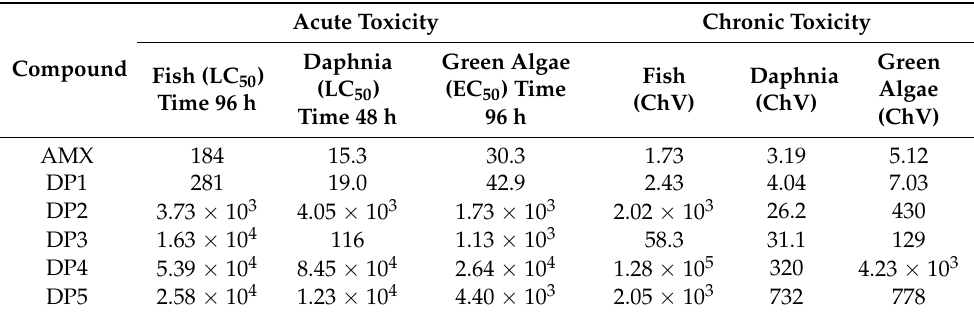
Table 1. Acute and chronic toxicities of AMX and its DPs towards fish, daphnia, and green algae in the units of mg/L.